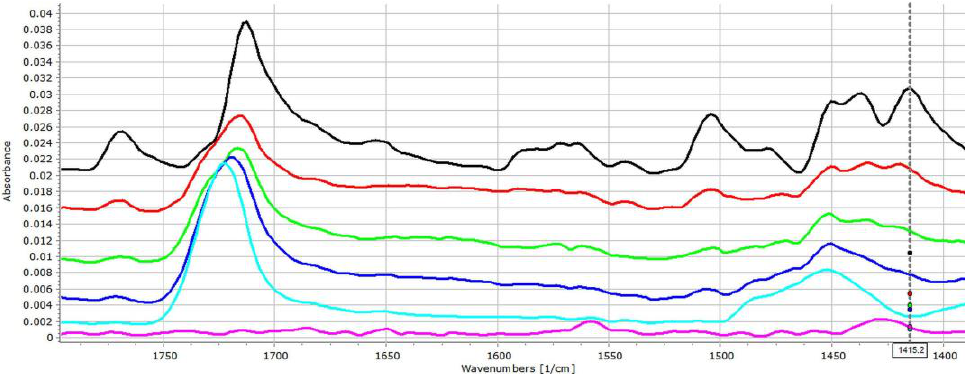
Figure 2. FT-IR spectra (1400 – 1800 cm −1 range) of the ACE ( black ), ACE-PVC:EE 75:25 ( red ), ACE- PVC:EE 50:50 ( green ), ACE-PVC:EE 25:75 ( deep blue ), EE ( light blue ) and PVC ( purple ) samples; multicursor indicates the place of peak shift in the spectrum.